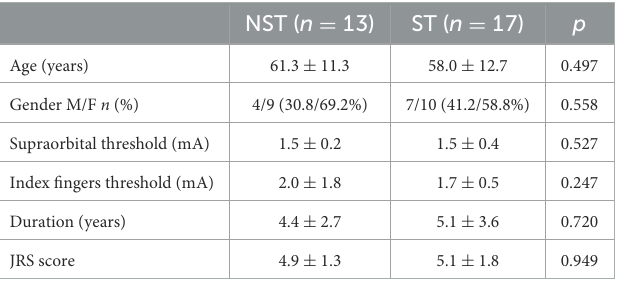
TABLE 2 Demographic and clinical characteristics of the NST and ST